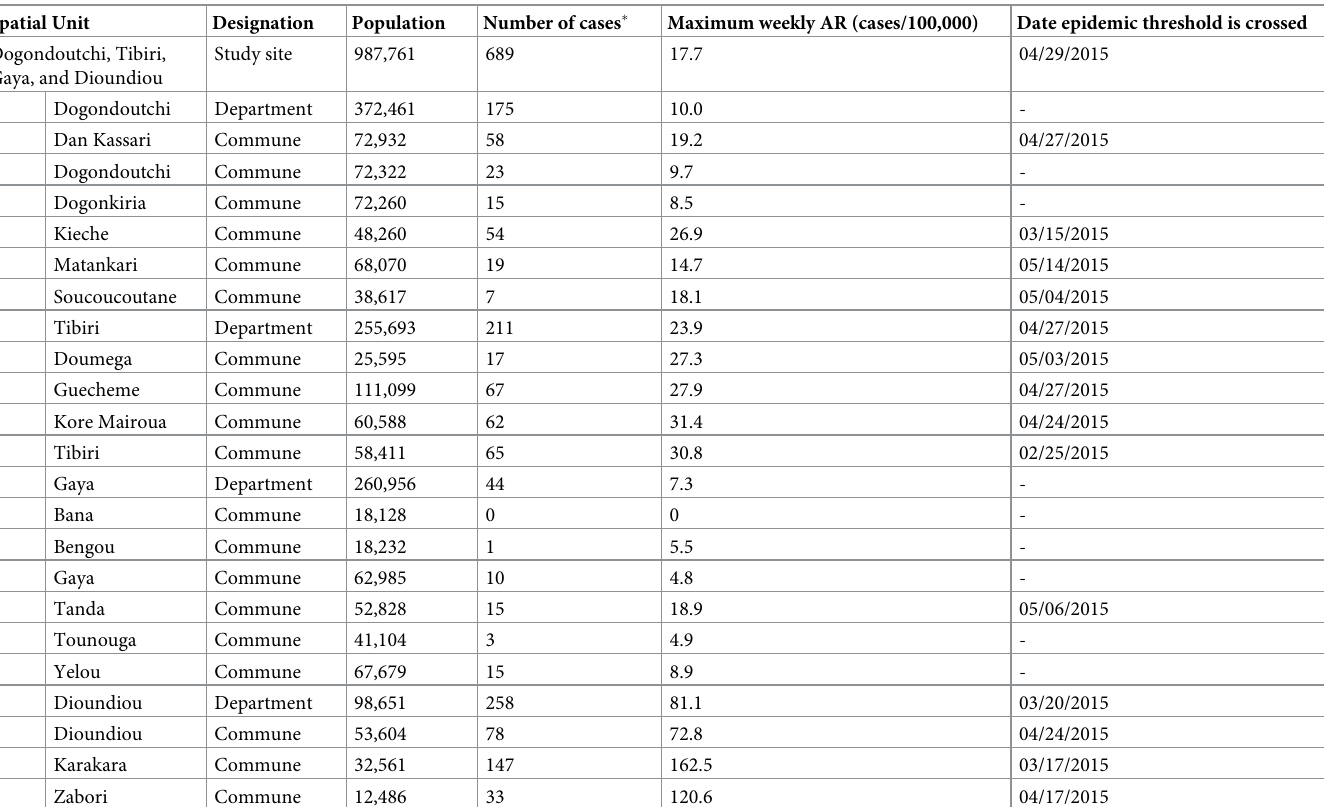
Table 1. Number of cases and population across study